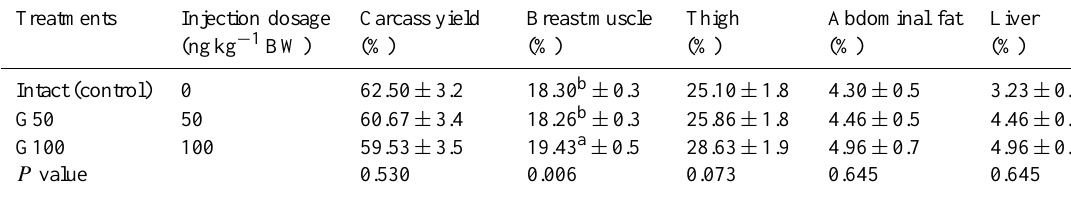
Table 3. Carcass traits 1 of geese subjected to IP injection of ghrelin.